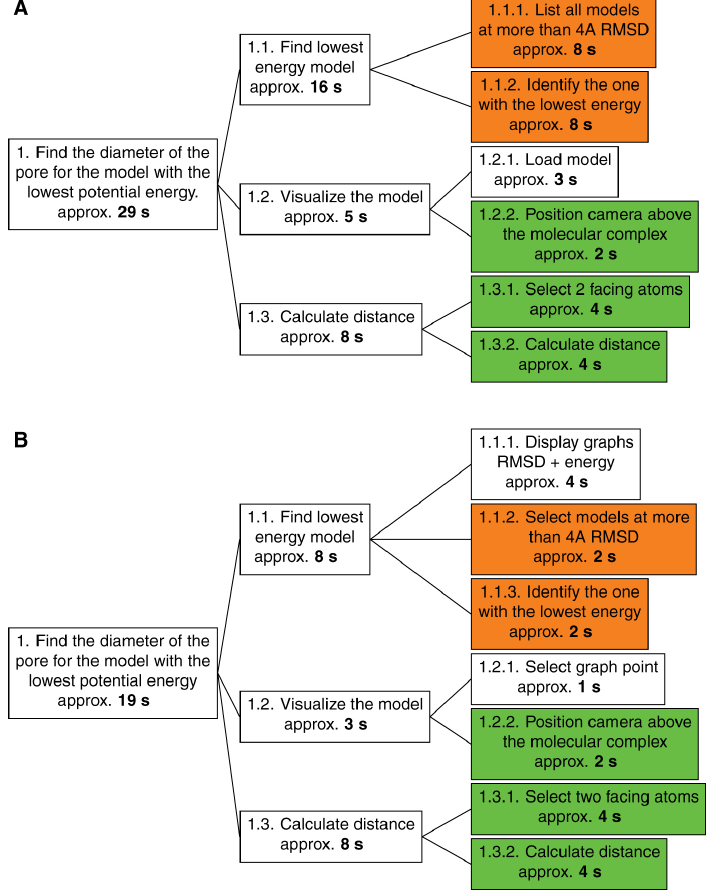
Figure 10: Subdivision by HTA of an expert task performed (A) in normal conditions and (B) within our platform